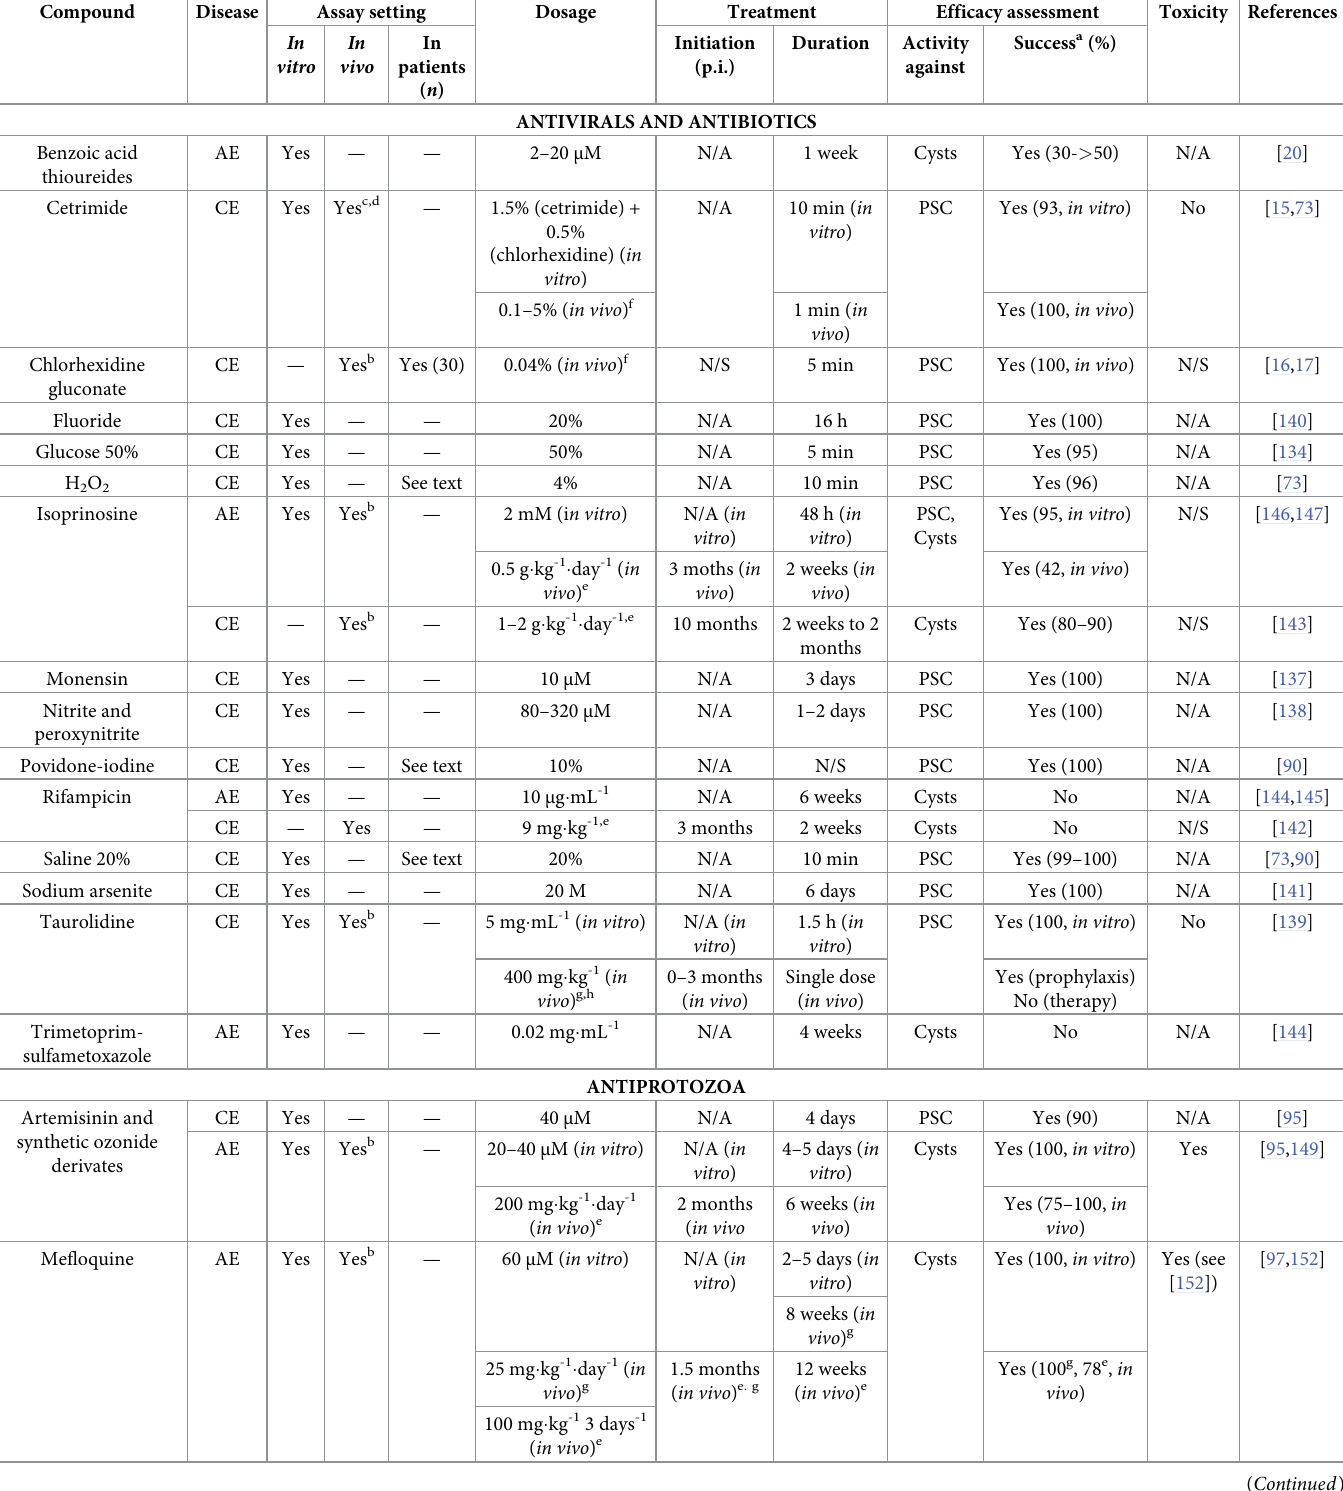
Table 3. Characteristics of synthetic compounds for the treatment of human cystic and alveolar echinococcosis based on the published literature.